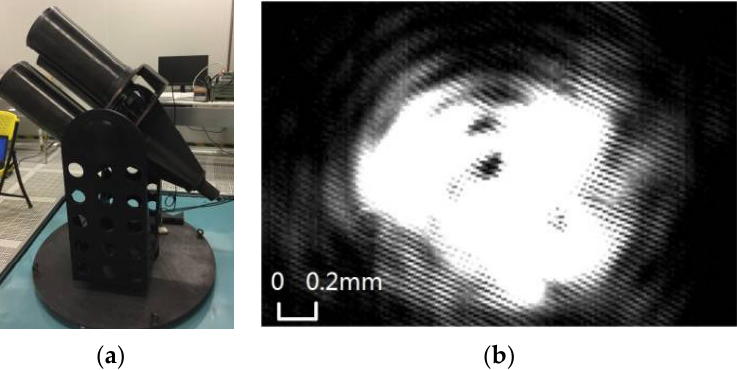
Figure 17. Rough adjustment of cophasing error: ( a ) Golay3 physical prototype; ( b ) point source experiment.